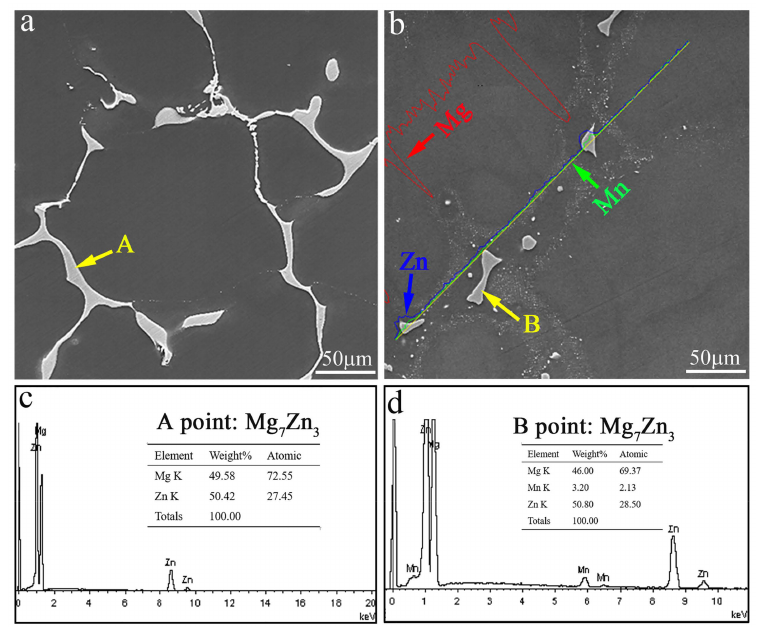
Figure 4. SEM (scanning electron microscopy) images of the ( a ) as-cast and ( b ) as-homogenized ZM51 alloys, and ( c , d ) corresponding EDS (energy dispersive X-ray spectrometer) results of the points in ( a , b ).